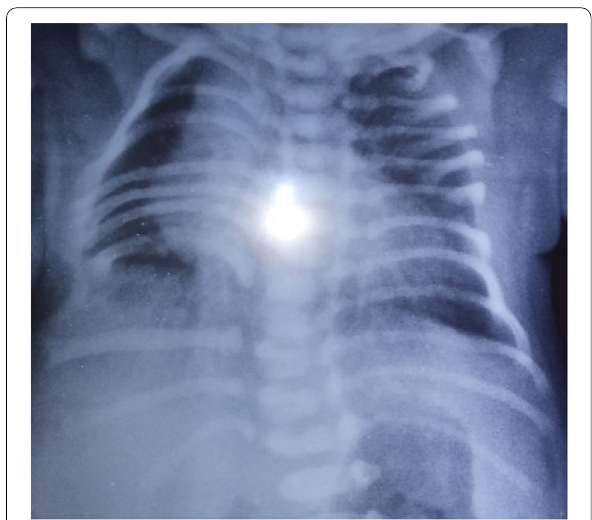
Fig. 2 Rib crowding, fanning, and fusion along with irregular shaped on chest radiograph with vertebral agenesis, hypoplasia, and fusion on whole spine